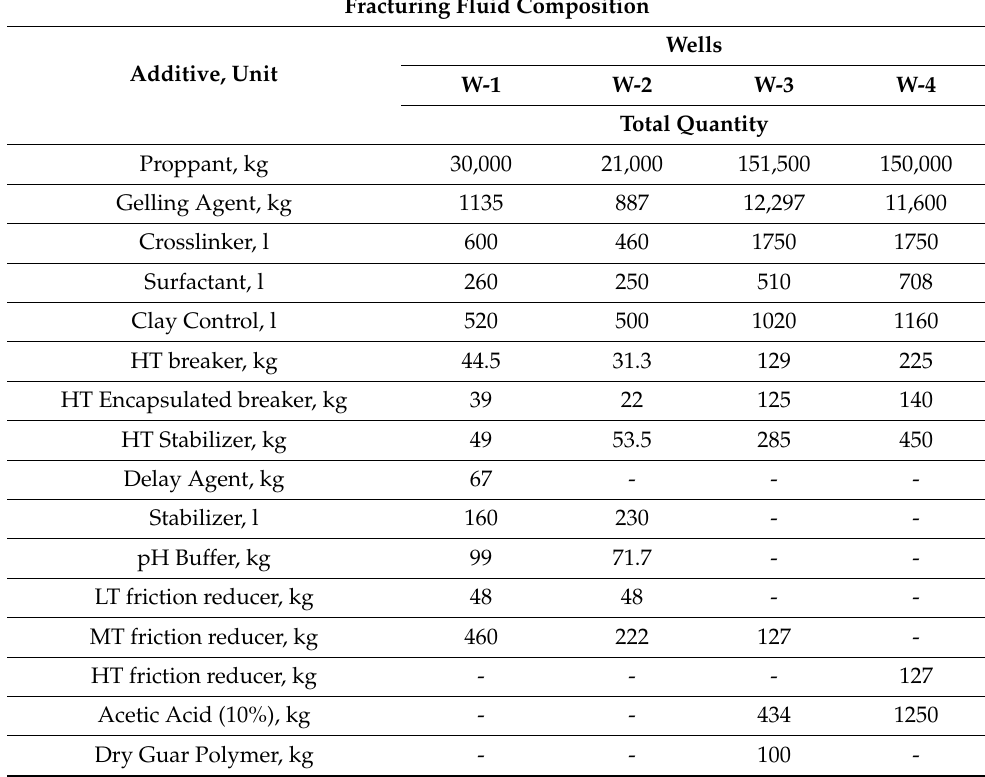
Table 15. Fracturing fluid